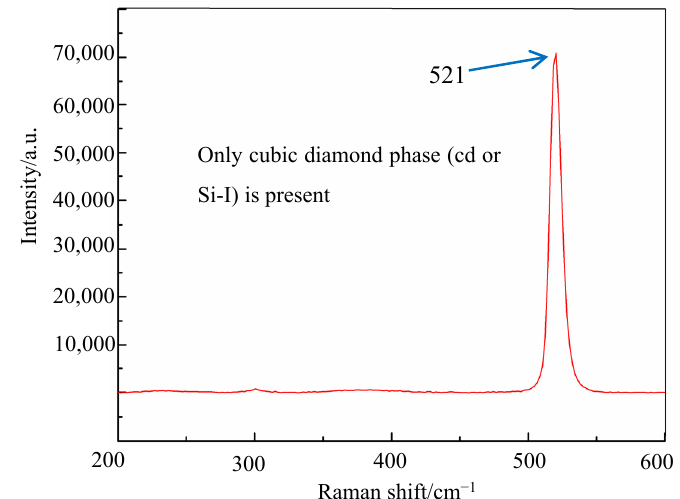
Figure 5. The Raman spectrum of single crystal silicon wafers.